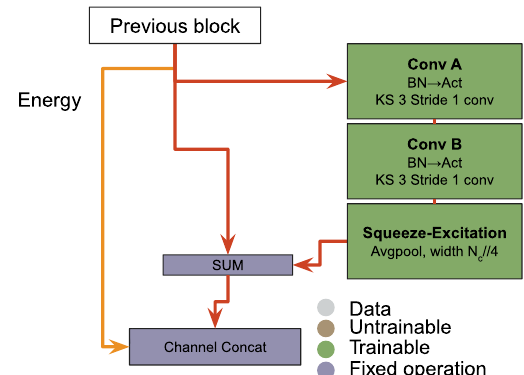
Models are trained to minimise a Huberised [51] version of the mean fractional squared error